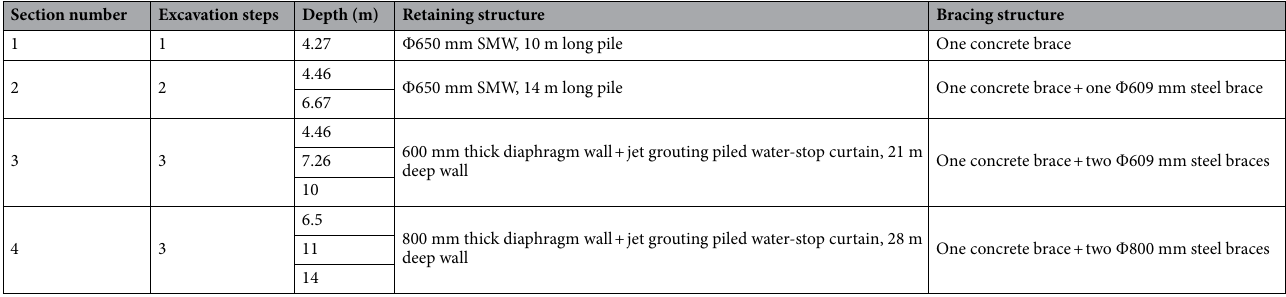
Table 2. Bracing and retaining methods.